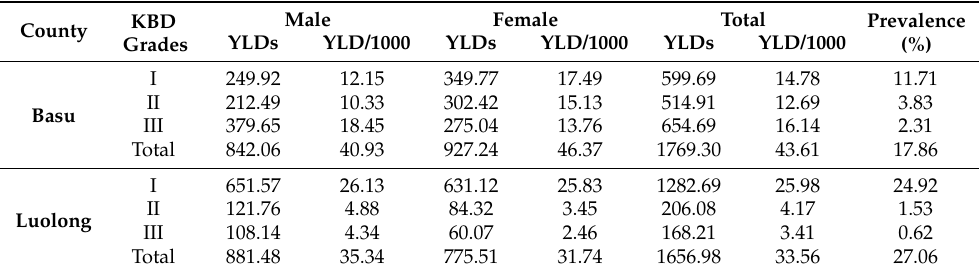
Table 1. Health loss from KBD in Basu and Luolong County